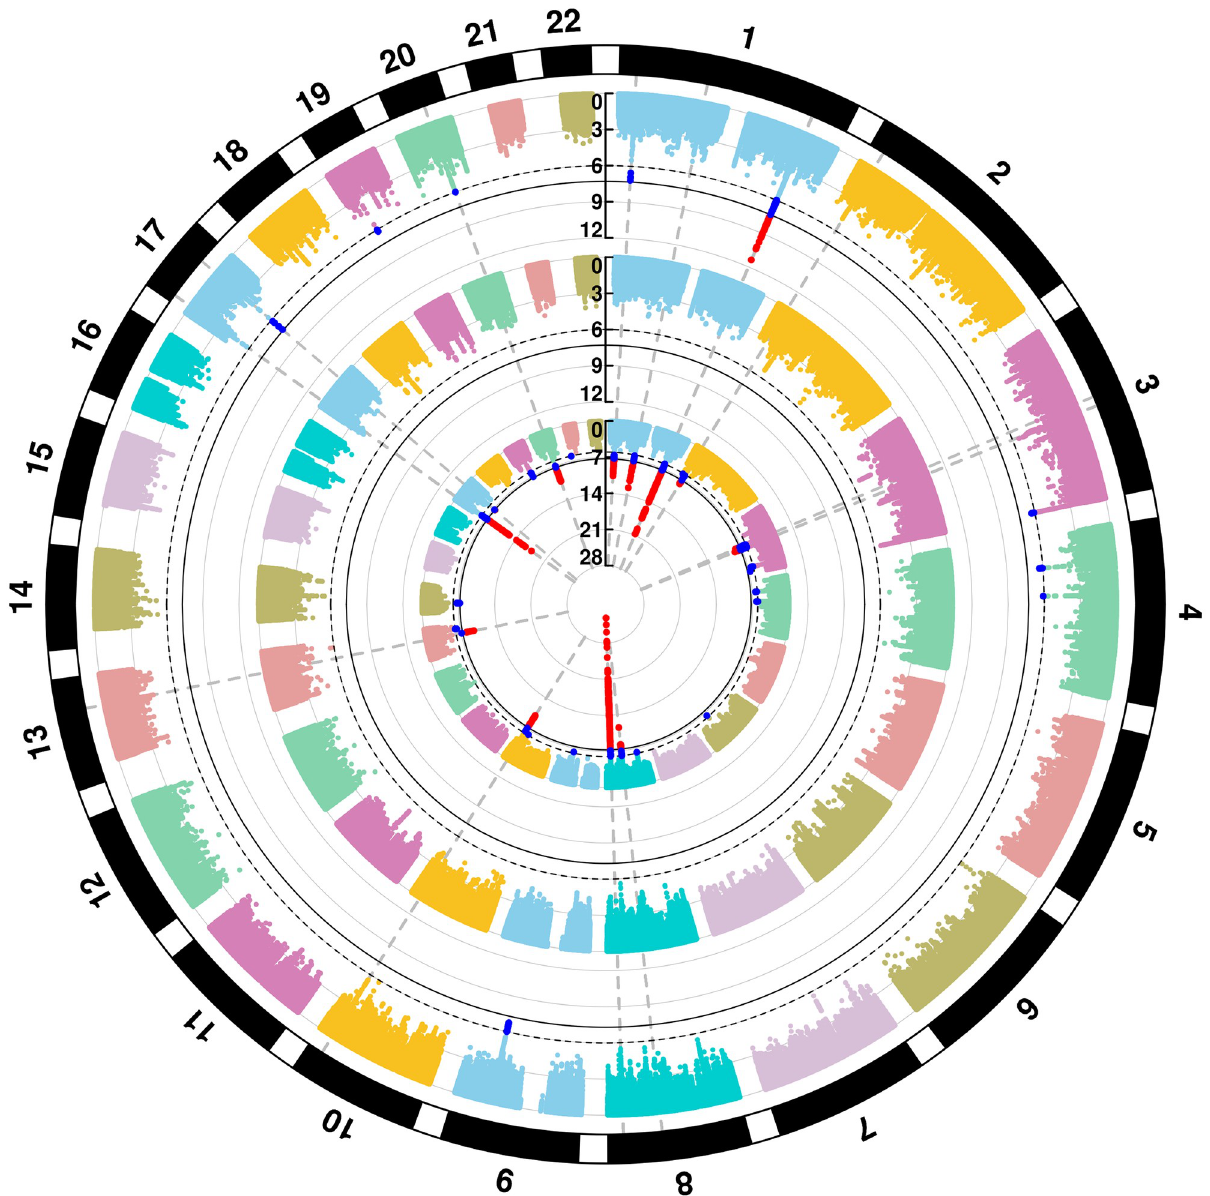
Fig 1. Manhattan plots for genome-wide analyses of OFC subgroups. The plots are of negative log-transformed p-values from the analysis of cleft lip with or without cleft palate (CL/P, innermost circle), of cleft palate (CP, intermediate circle), and of genetic overlap between CL/P & CP using PLACO (outermost circle). The chromosome numbers 1–22 are indicated along the outermost circumference. Solid black and dashed black circular lines are used in all plots to indicate the conventional genome-wide significance threshold 5 × 10 − 8 and a less stringent suggestive threshold 10 − 6 respectively. The variants exceeding the genome-wide and the liberal thresholds are respectively colored in red and bright